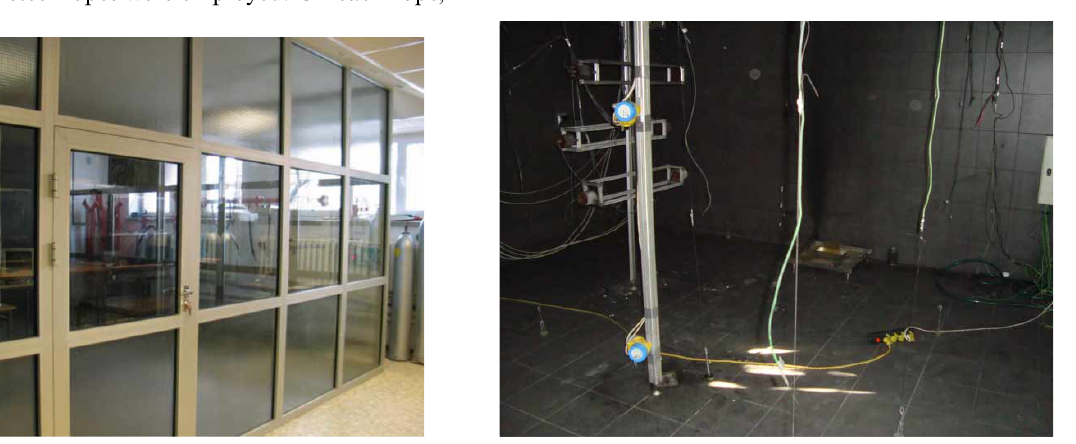
Fig. 2. An external view of the test chamber Fig. 3. An internal view of the test